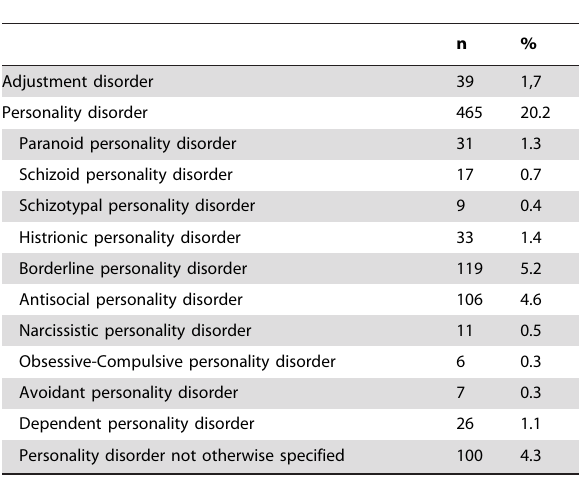
Table 4. Prevalence of adjustment and personality